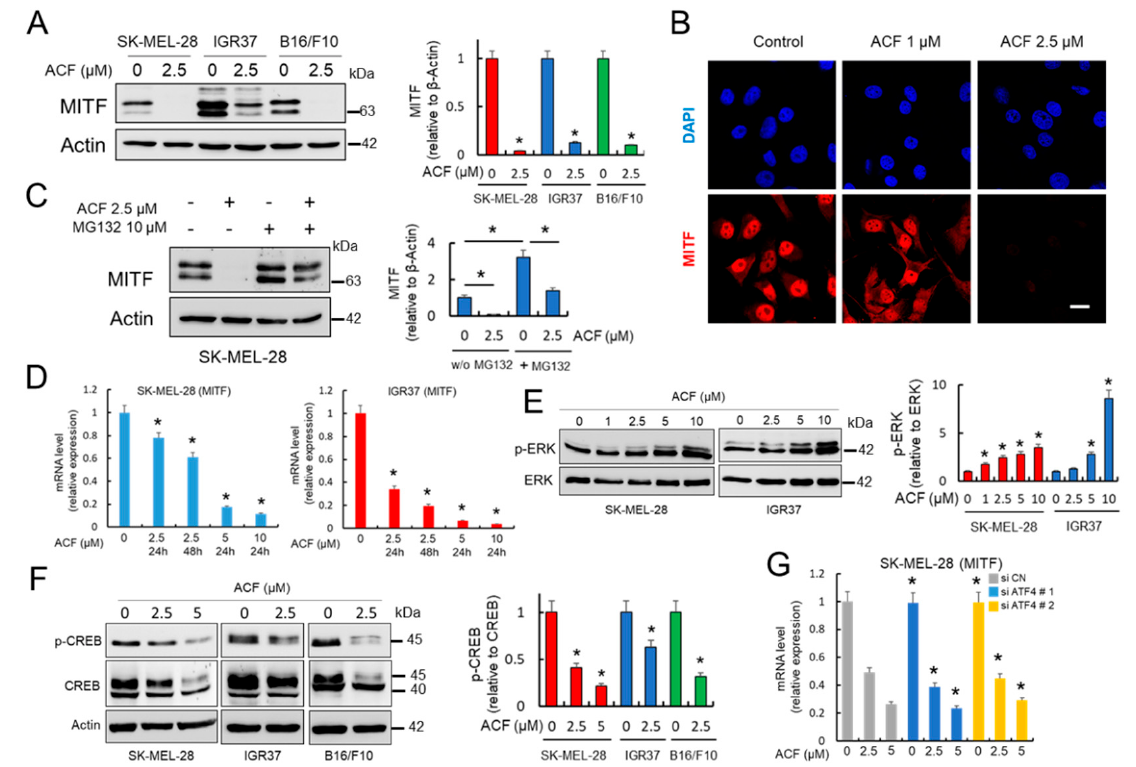
Figure 3. ACF decreases MITF expression in melanoma cells. ( A ) Effect of ACF (24 h) on MITF expression in melanoma cells analyzed by western blot. IOD quantification is shown (histogram; * p < 0.05 when compared with untreated controls). ( B ) Confocal microscopy analysis (63X magnification) of MITF in SK-MEL-28 melanoma cells under indicated conditions (cells were treated with ACF for 24 h). Bars, 27 µ M. ( C ) Western blot experiments for the effect of ACF on MITF expression in the absence or the presence of MG132. SK-MEL-28 cells were treated for 12 h with ACF alone or simultaneously co-treated with ACF and MG132. * p < 0.05 when comparing indicated data groups. ( D ) qRT-PCR analysis of MITF mRNA in indicated melanoma cells before and after ACF treatments (24 h). Relative mRNA expression in treated cells was normalized with respect to untreated cells. * p < 0.05. ( E ) Effect of ACF (24 h) on the phosphorylation of ERK1/2 (p-ERK) in melanoma cells analyzed by western blot. Specific antibodies recognized the diphosphorylated forms of ERK1/2 (Thr183 and Tyr185 based in ERK2 nomenclature). Constitutive total ERK was used as a reference for p-ERK expression. IOD quantification is shown (histogram; * p < 0.05 when compared with untreated controls). ( F ) Effect of ACF (24 h) on Ser133 phosphorylation in CREB (p-CREB). Western blot of total CREB showed two clear bands at 40 and 45 kDa, corresponding to the upper band to phosphorylated CREB. IOD quantification is shown (histogram; * p < 0.05 when compared with untreated controls). ( G ) Effective silencing of ATF4 with two different siRNAs (Figure 2F) did not influence MITF-mRNA expression in SK-MEL-28 cells. * not significant when compared to siATF4 samples with their respective treatments in siCN samples. When indicated, cells were treated with ACF for 24 h.